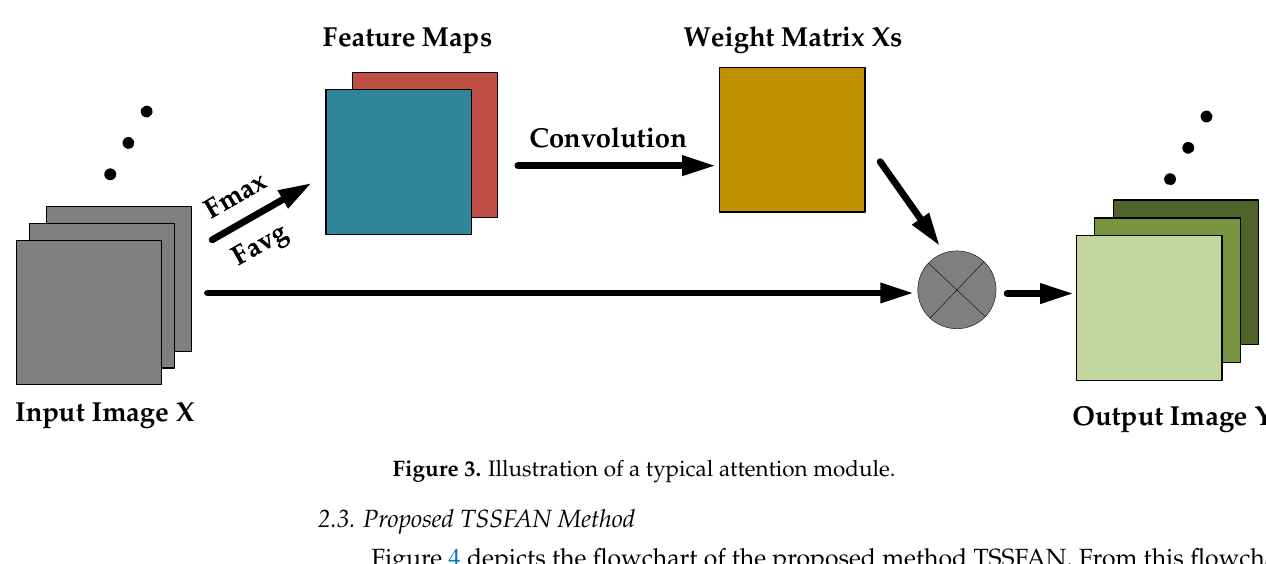
Figure 3. Illustration of a typical attention module.